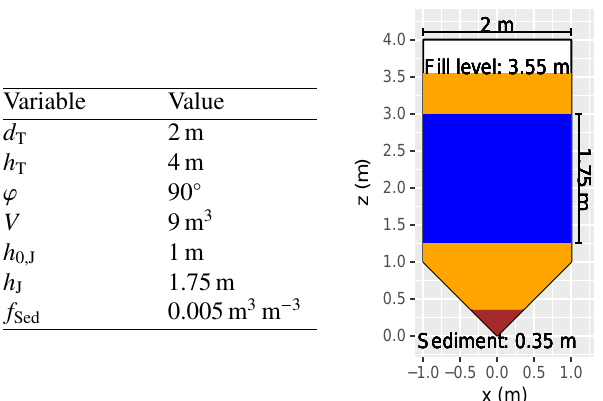
Figure 2. Exemplary geometrical input data with corresponding 2D tank sketch.